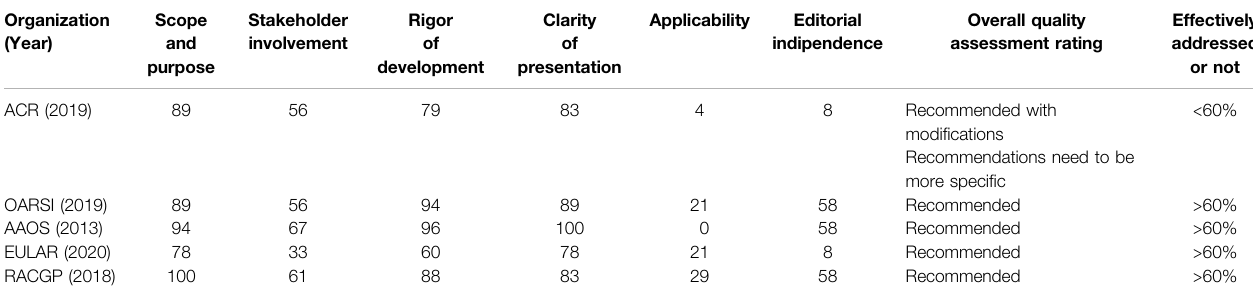
TABLE 1 | Intra-articular steroid injection, hyaluronic acid injection and platelet rich plasma injection recommendations